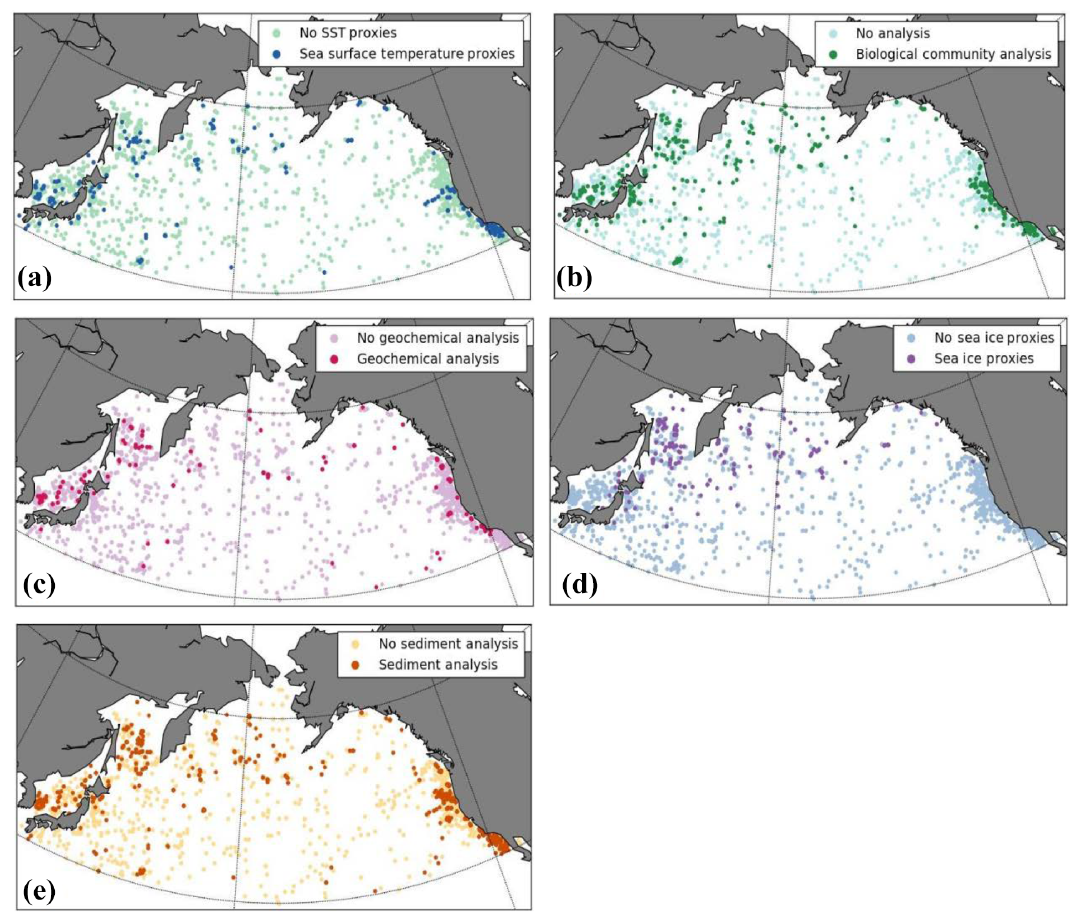
Figure 3. Published paleoceanographic proxies in the North Pacific. (a) Sea surface temperature reconstructions, including planktonic foraminifera oxygen isotopes ( δ 18 O p ), magnesium to calcium measurements, and TEX 86 and U k alkenones. (b) Biostratigraphy of micro- 37 fossils, including foraminifera, diatoms, radiolarians, ostracods, silicoflagellates, ebridians, acritarchs, coccolithophores, and dinoflagellates. (c) Geochemical proxy analysis, including trace metals such as brassicasterol, magnesium, calcium, molybdenum, cadmium, manganese, uranium, chromium, rhenium, chlorin, titanium, iron, zinc, and beryllium. (d) Presence of sea ice proxies, including geochemical biomarker IP25, ice-rafted debris (IRD), and sea-ice-related diatom communities. (e) Analysis of lithological core proxies, including 395 measurements of core lamina, biogenic opal and barium, silicon to aluminum weight ratio, sulfur, inorganic 20 and organic carbon weight and mass accu- mulation rates, mass accumulation rates of various elements, inorganic nitrogen, carbon to nitrogen ratios, sediment density, and clay mineral